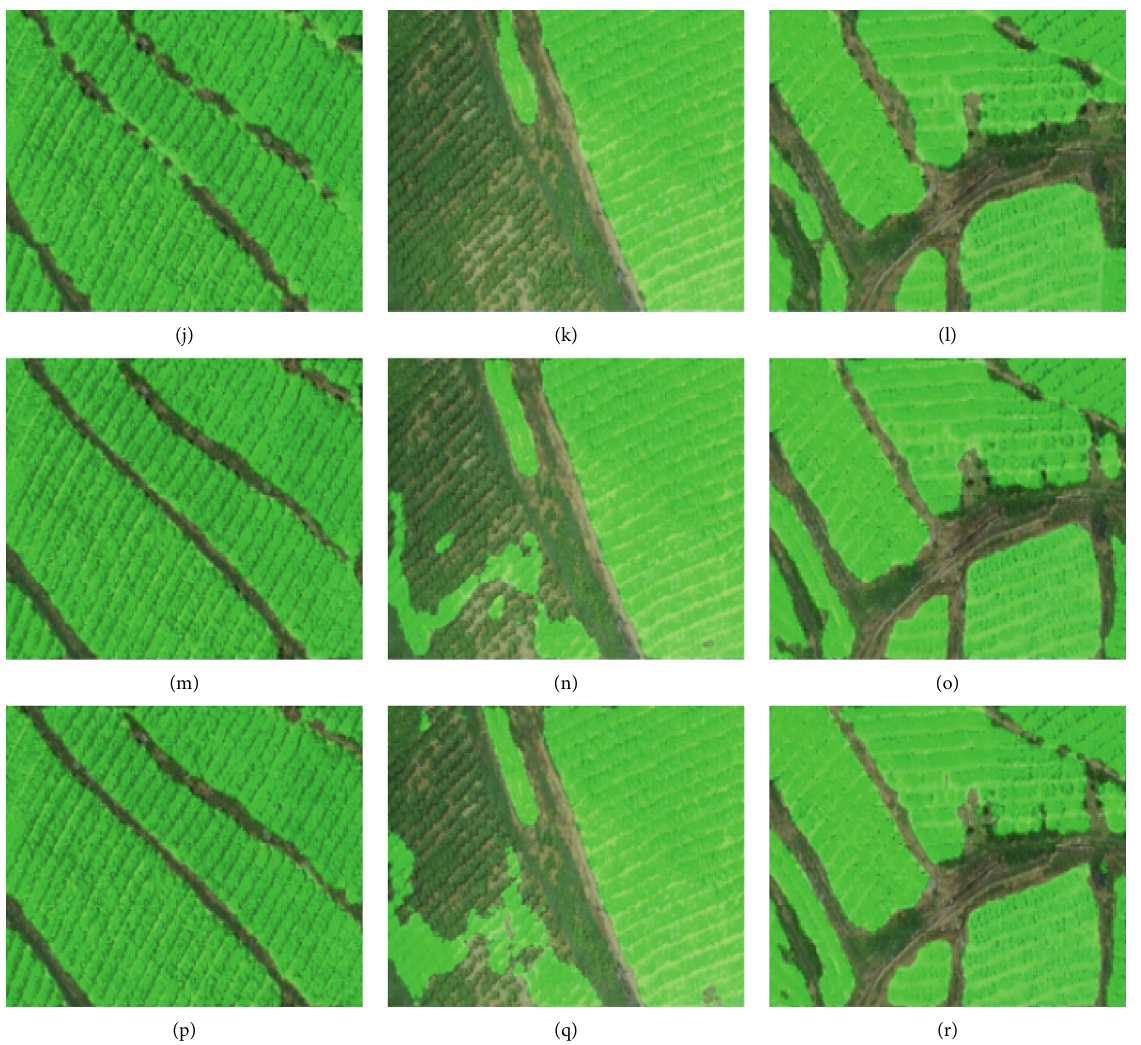
Figure 8: Semantic segmentation results of four kinds of networks: (a) sample data 1; (b) sample data 2; (c) sample data 3; (d) label data of sample data 1; (e) label data of sample data 2; (f) label data of sample data 3; (g) DeeplabV3+ result of sample data 1; (h) DeeplabV3+ result of sample data 2; (i) DeeplabV3+ result of sample data 3; (j) PSPNet result of sample data 1; (k) PSPNet result of sample data 2; (l) PSPNet result of sample data 3; (m) SegNet result of sample data 1; (n) SegNet result of sample data 2; (o) SegNet result of sample data 3; (p) U-Net